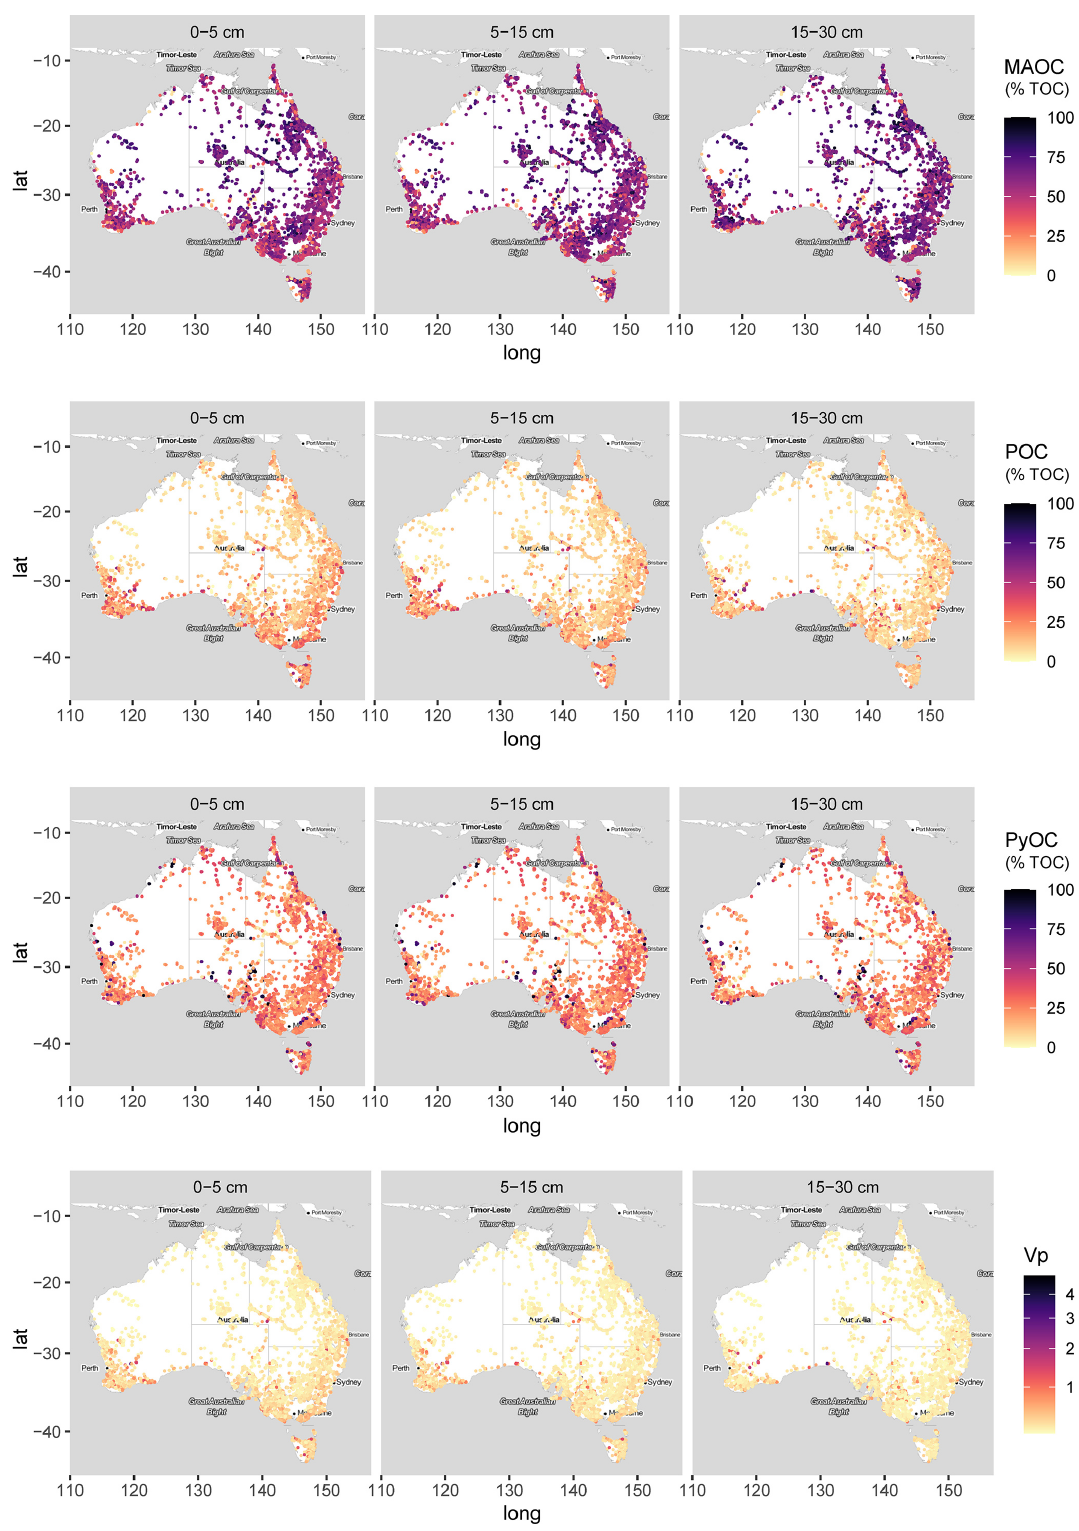
Figure 2. Locations of the spectral predictions standardised for the depths 0–5, 5–15, and 15–30cm used as input data for digital soil mapping. Contribution of SOC fractions to total organic carbon (% TOC): MAOC, POC, PyOC, and Vp.